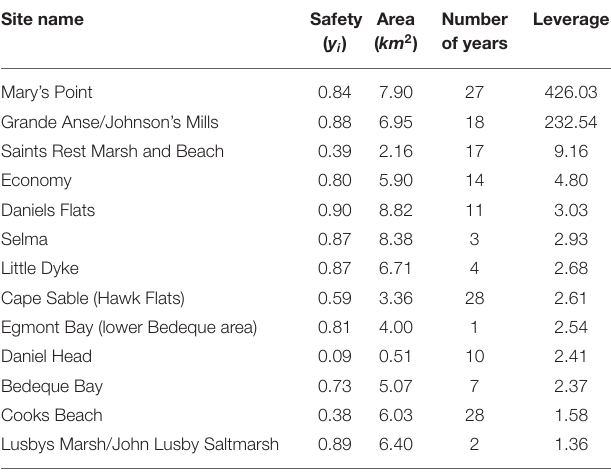
TABLE 2 | Sites with the most influence on the Priority Matching Distribution index across all years within the survey